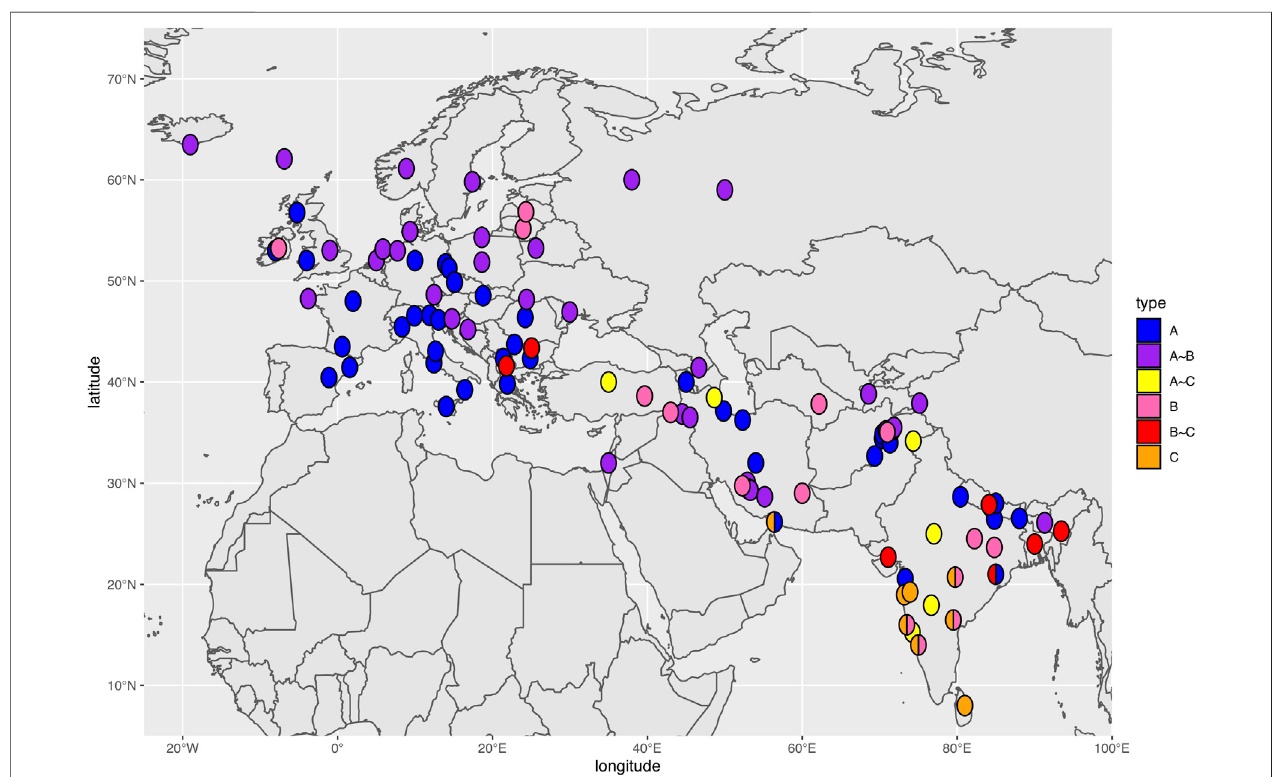
FIGURE 3 | An overview of negative existential construction types in Indo-European languages, overlaid on a map of western Eurasia.